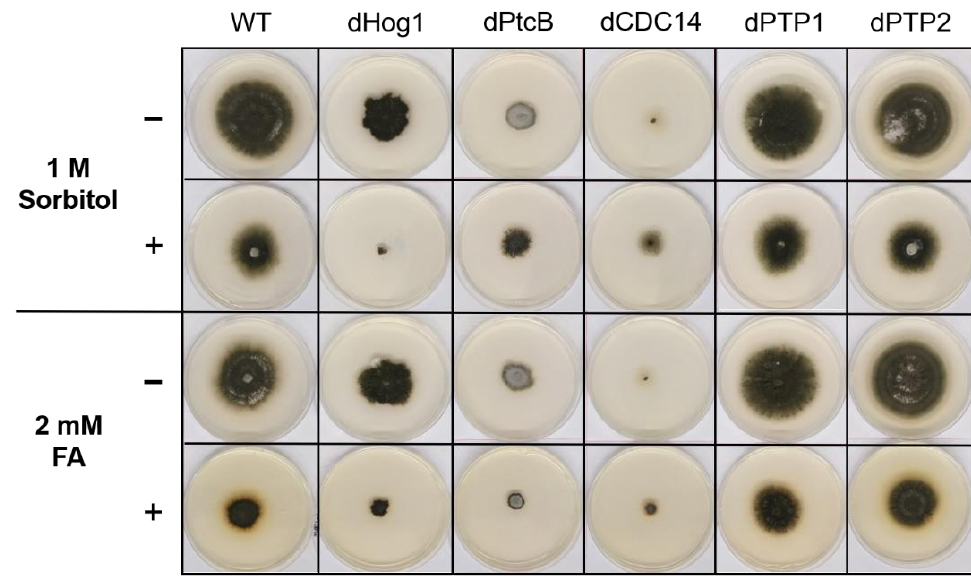
Figure 4. Colony phenotypes under osmotic stress or FA treatment. The cultures were grown for 6 days following their inoculation on CM agar plates with or without sorbitol ( − or + 1 M sorbitol), or CM with 0.15% v/v DMSO with or without FA ( − or + 2 mM FA).